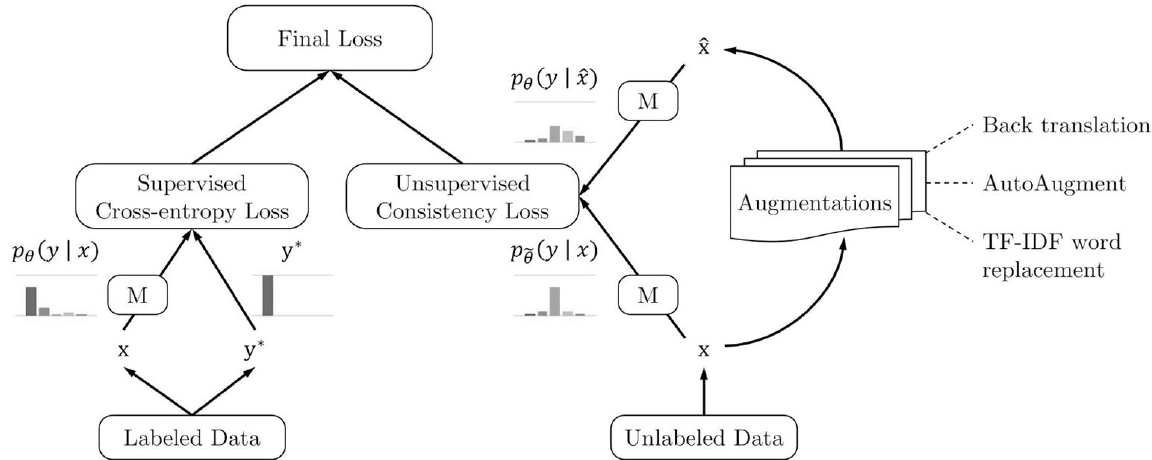
Figure 5. The description of the UDA technique as of the original paper